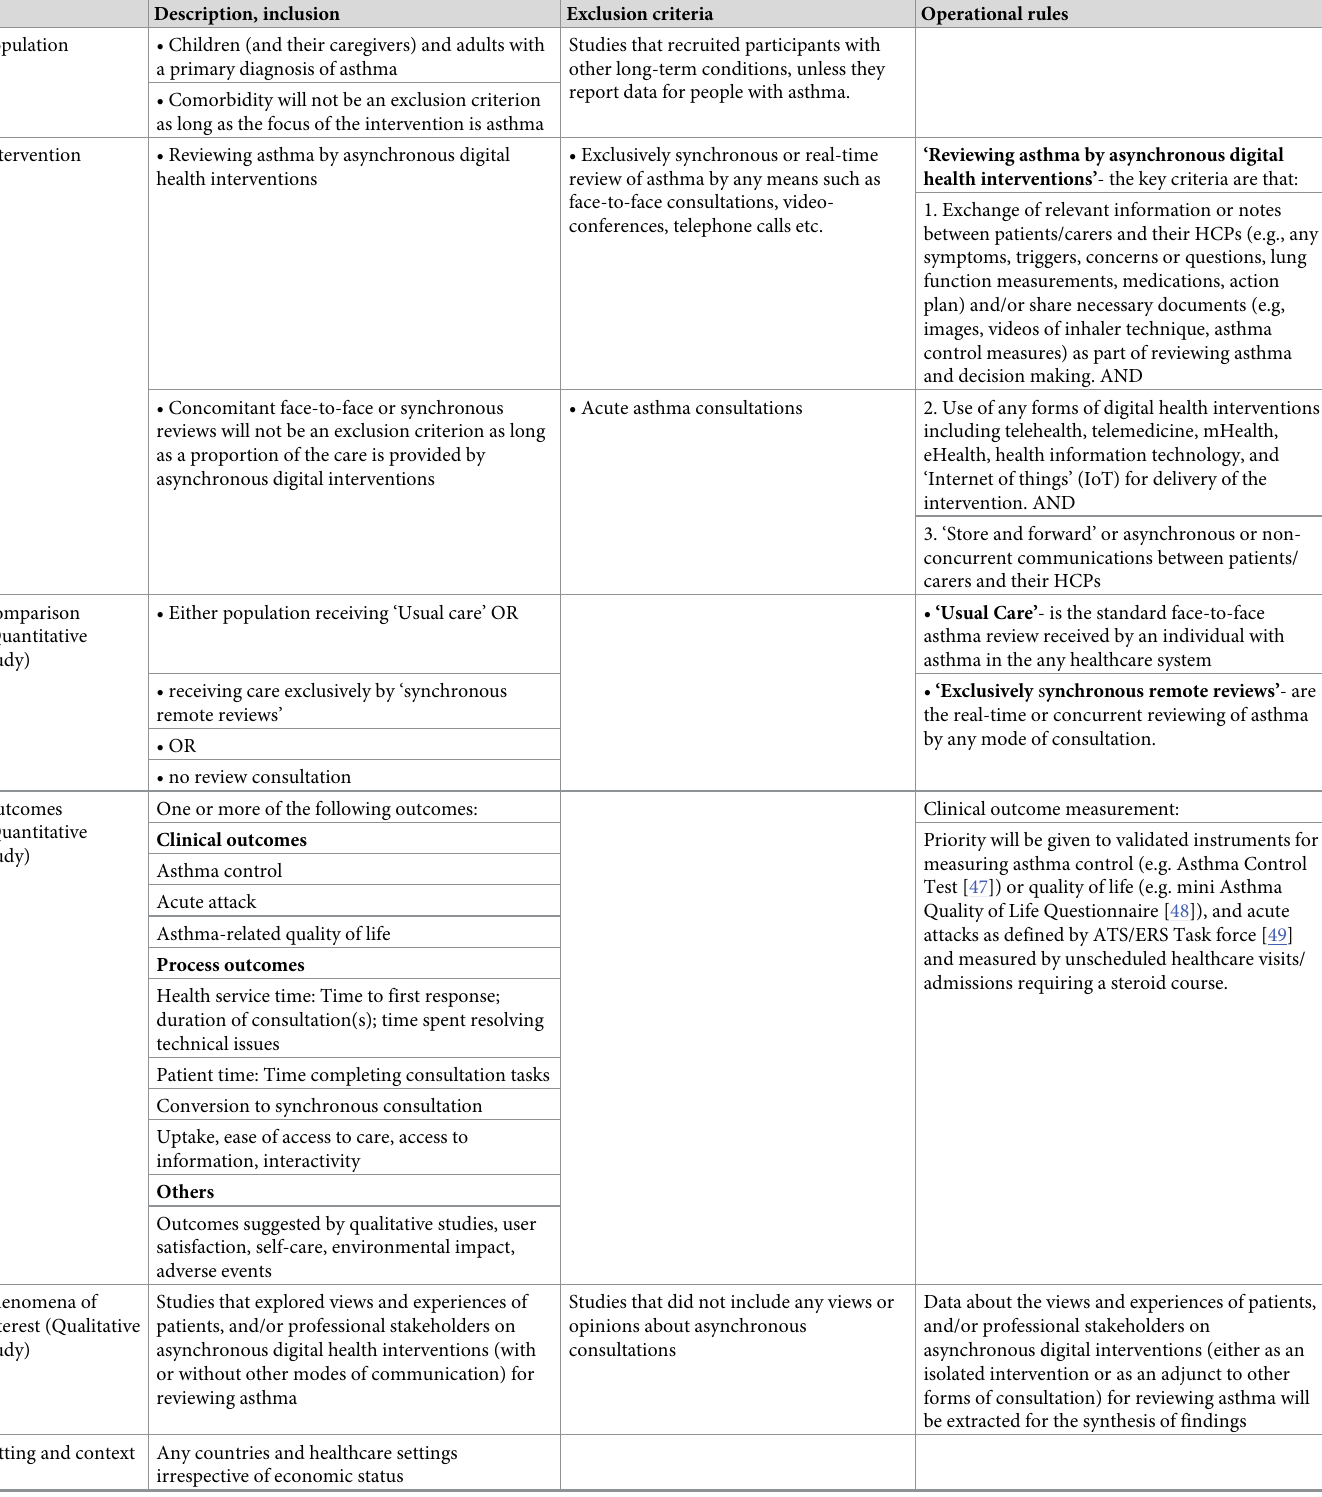
Table 2. Inclusion and exclusion criteria, and operational